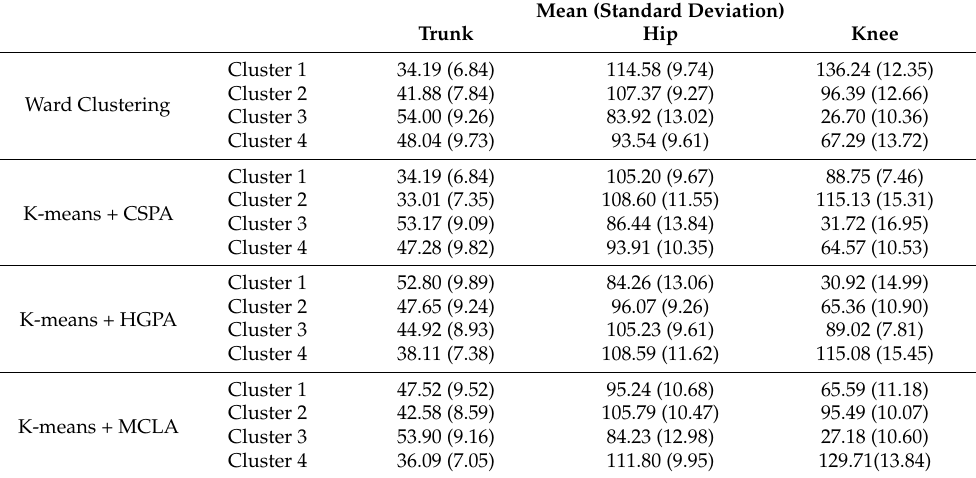
Table 2. Descriptive statistics (mean (SD)) of trunk, hip and knee range of motion for each cluster between methods.